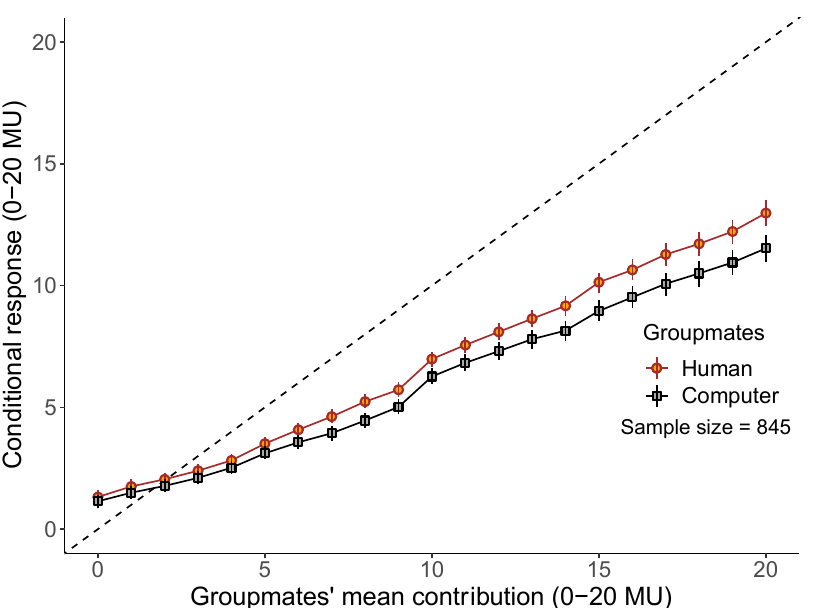
Figure 1. Conditional cooperation with computers. Mean conditional contributions and 95% bootstrapped confidence interval for each average contribution level of either human (orange circles) or computerized (grey squares) groupmates (dashed diagonal = perfect matching).